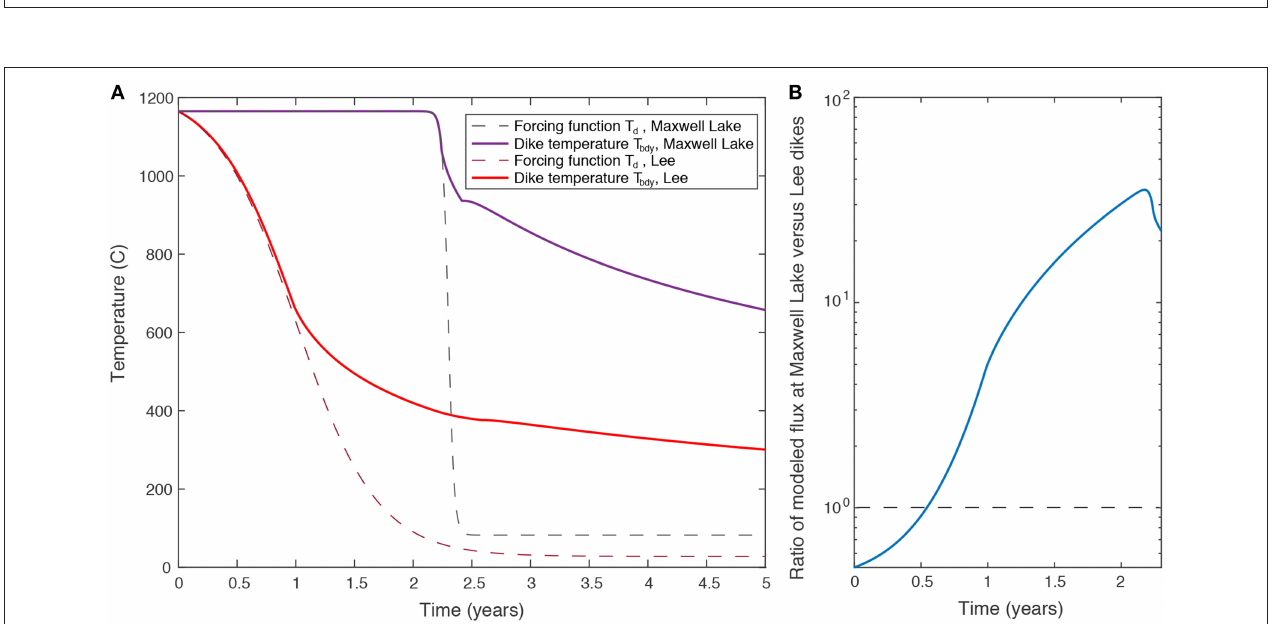
FIGURE 12 | (A) Time variation of predicted Maxwell Lake and Lee dike contact temperatures T bdy taking parameters τ c , τ w , k , and T BG from the median of MCMC posterior distributions ( Table 1 ). Dashed line is the forcing function T d from Equation (11). T bdy diverges from T d in time due to thermal buffering from heated wall rocks. (B) Predicted ratio of flux between Maxwell Lake and Lee dikes from Equation (18). Dashed line is equal flux, values greater than unity indicate larger flux from Maxwell Lake dike.